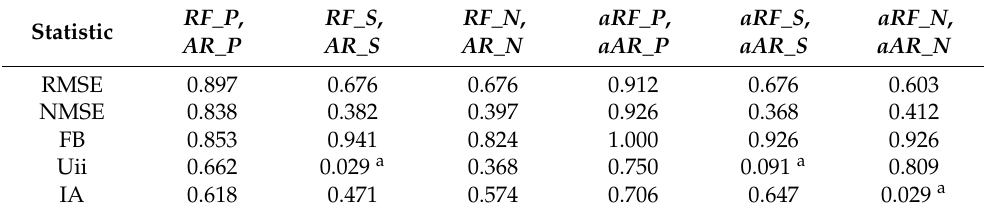
Table 6. Kendall’s correlations for comparison of the forecast accuracy, calculated using the two methods, RF and Arc-x4, for 17 period steps, each one for a prediction horizon of h = 10 steps ahead. RF_P , RF_S , RF_N , aRF_P , Statistic AR_P AR_S AR_N aAR_P RMSE NMSE